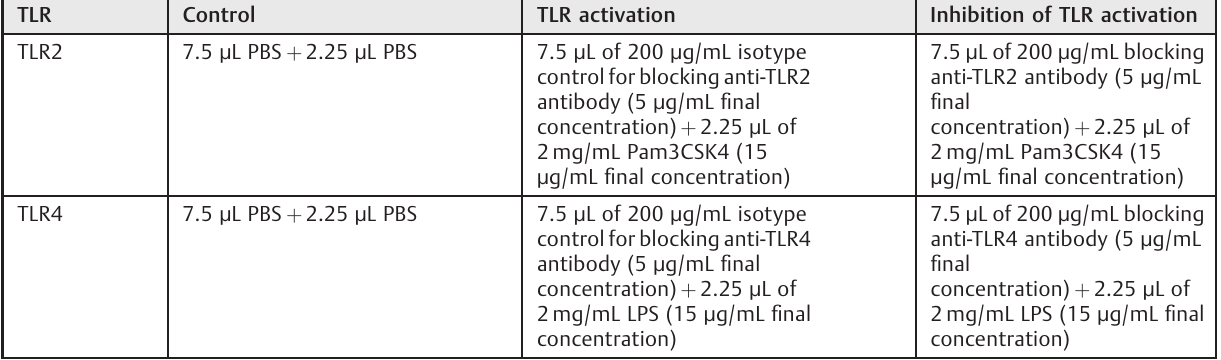
Abbreviations: LPS, lipopolysaccharides; TLR, toll-like receptor. Note: Reagents as depicted are added to 300 µL of platelet – neutrophil mixture in each